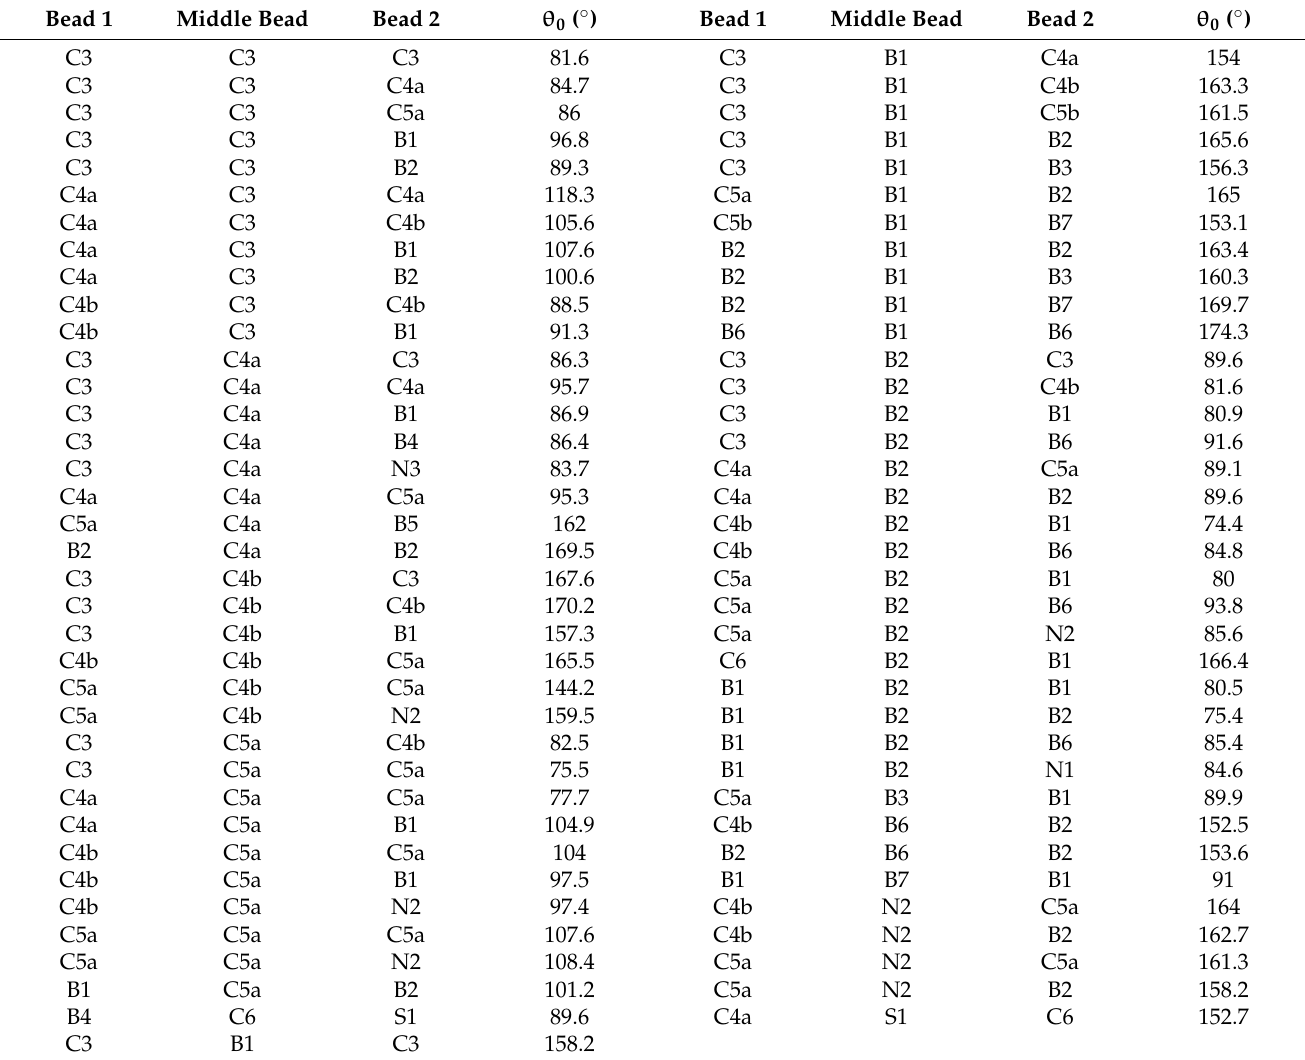
Table 7. Force field parameter θ 0